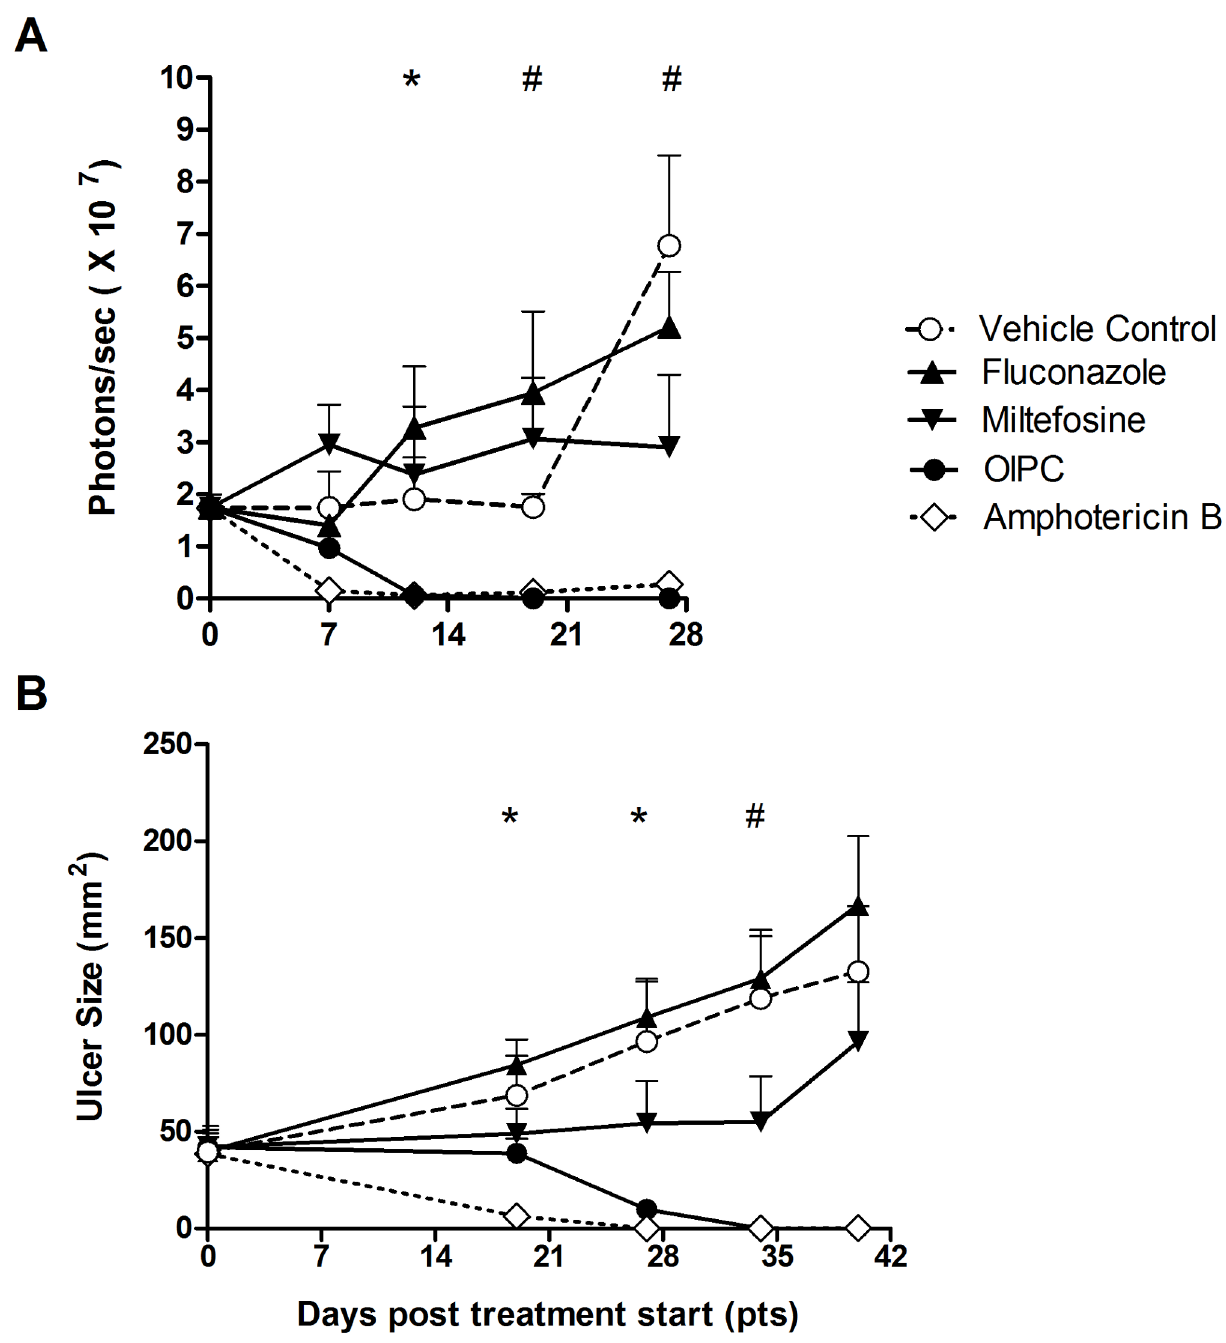
Figure 1. Invivo efficacy of oral OlPC against L.major in comparison with other antileishmanial drugs. BALB\c mice were infected with luciferase-labeled L. major promastigotes at the tail base. When lesions reached , 50 mm 2 oral treatment with OlPC (40 mg/kg/day), miltefosine (40 mg/kg/day), fluconazole (160 mg/kg/day), or vehicle control (PBS) was initiated for 21 consecutive days (Day 0–Day 20). Amphotericin B was given intraperitoneally (IP) at 25 mg/kg/day for 10 days (Day 0–Day 9). Parasitemia (A) was measured in every group by in vivo imaging (IVIS) on a weekly basis until Day 28 post treatment start and expressed as number of total photons emitted per second. Ulcer sizes (B) were measured weekly using a calibrated digital caliper. Mean 6 SEM is shown. * amphotericin B P , 0.05 compared to vehicle control. # amphotericin B and OlPC P , 0.05 compared to vehicle control.